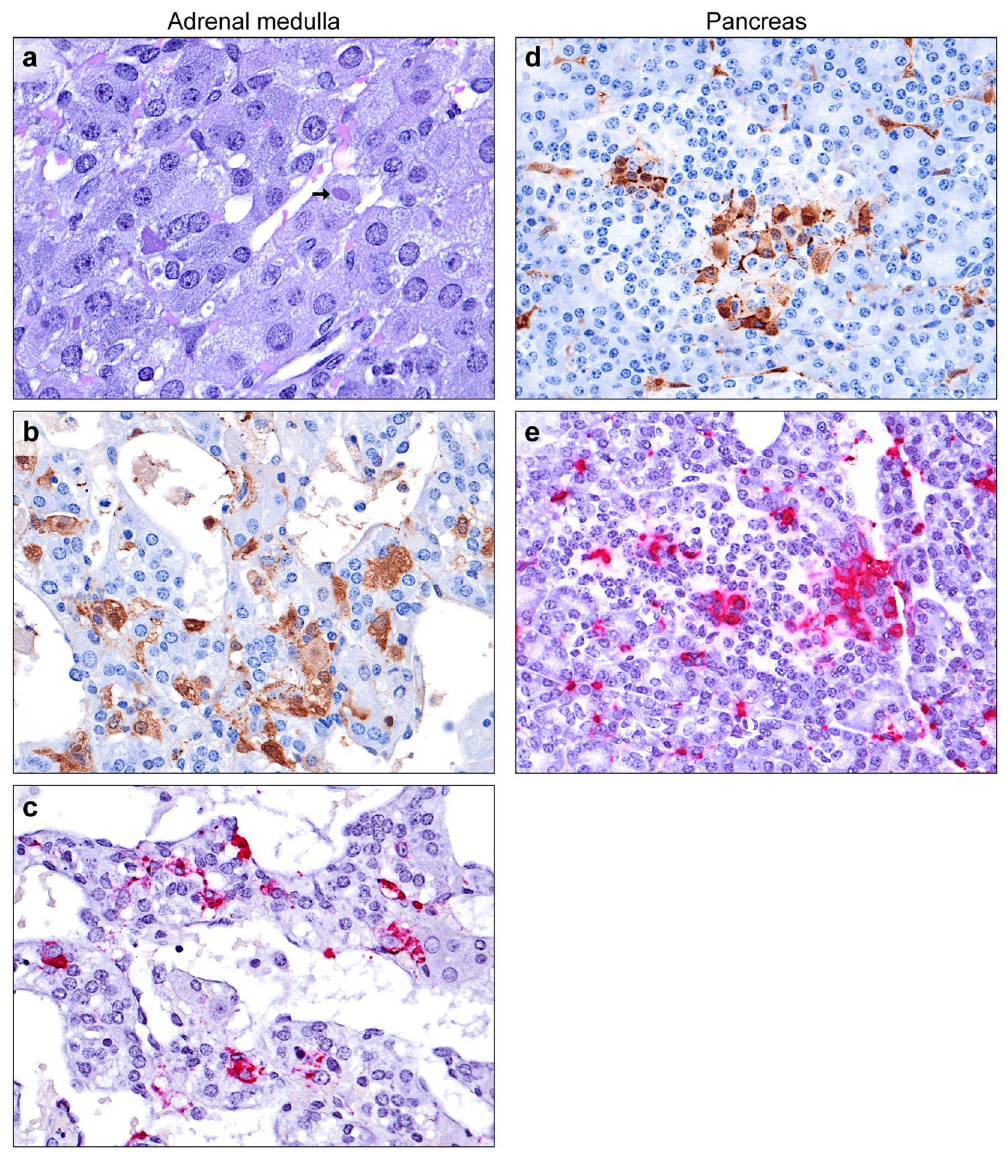
( c ) EBOV-infected chromaffin cells (EBOV NP ISH: fast red chromogen and hematoxylin). ( d and e ) EBOV- infected endocrine cells of the Islets of Langerhans, exocrine acinar cells, and interstitial fibroblasts and macrophages ( d : EBOV VP40 IHC: DAB chromogen and hematoxylin, e : EBOV NP ISH: fast red chromogen and